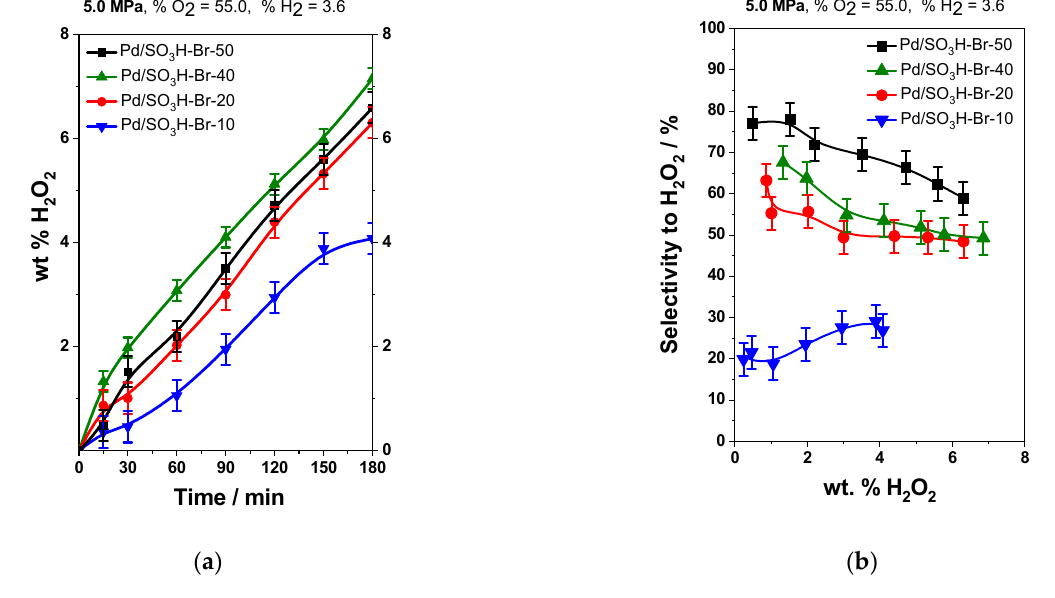
Figure 4. ( a ) H 2 O 2 concentration profiles versus time at 313 K and 5.0 MPa; ( b ) Influence of the amount of bromide in the supports on the selectivity for H 2 O 2 .